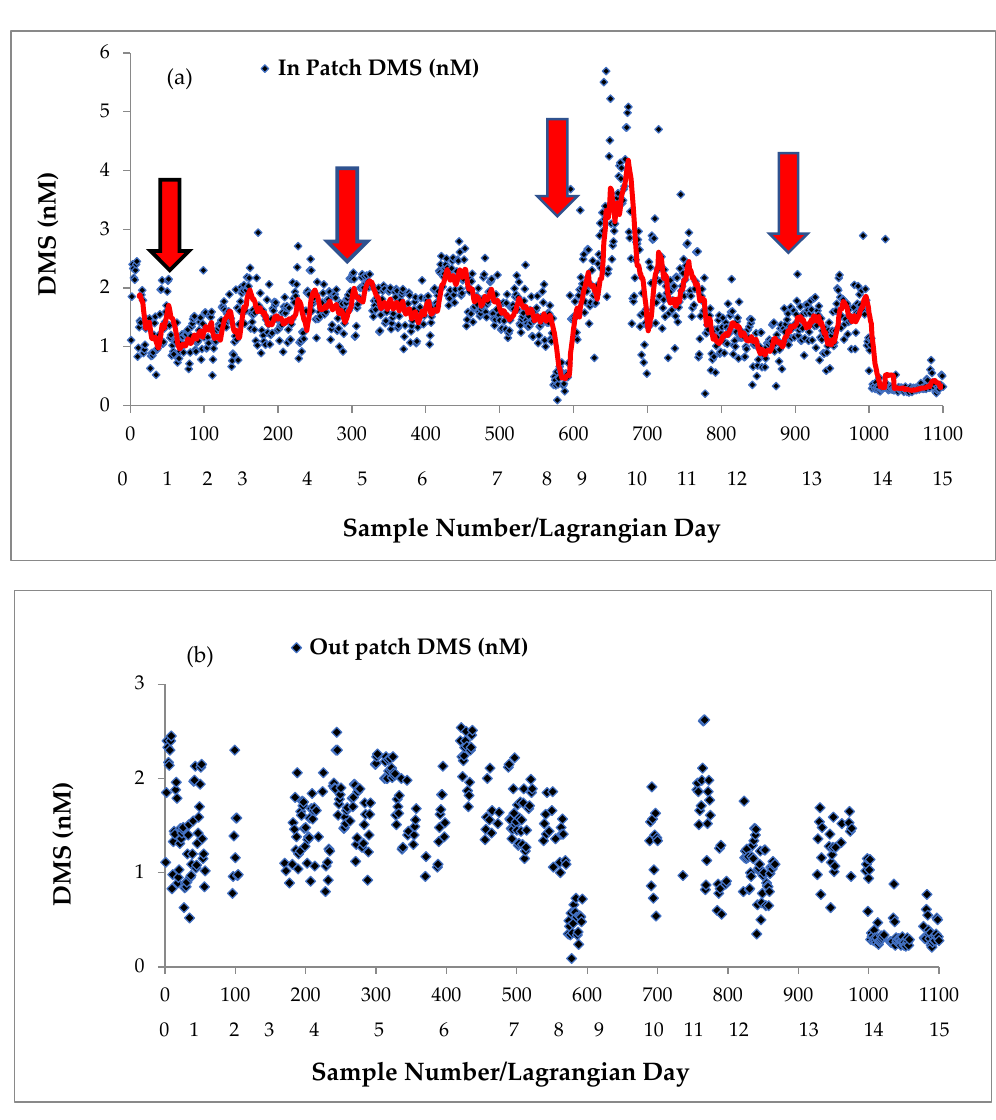
Figure 4. Surface seawater underway dimethylsulfide (DMS) (nM) concentrations for the ( a ) IN patch (iron enrichment = red arrows) and ( b ) OUT patch, versus sample number and Lagrangian day (red line in ( a ) 12-point moving average).